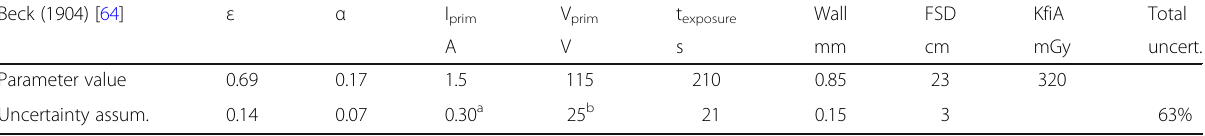
Table 8 Uncertainty estimate for a case with information on primary and secondary circuit Beck (1904) [64]